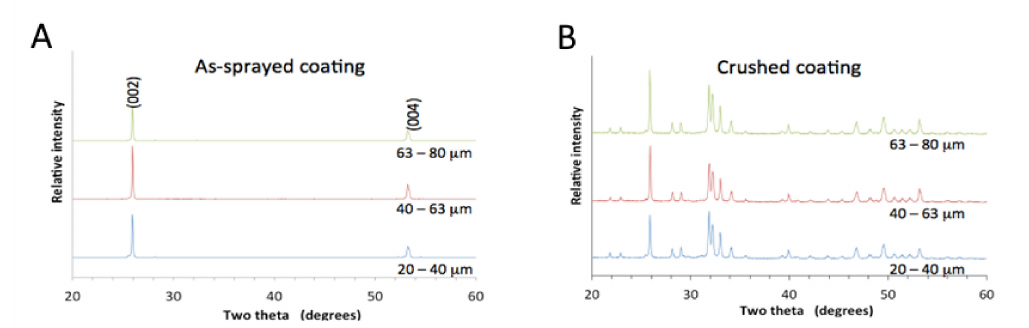
Figure 2. X-ray di ff raction of ( A ) coatings showing a < 001 > crystal orientation and of ( B ) crushed coatings displaying peaks characteristic of hydroxyapatite. Coatings were made from 20–40 µ m powder, 40–60 µ m powder and 60–80 µ m powder.